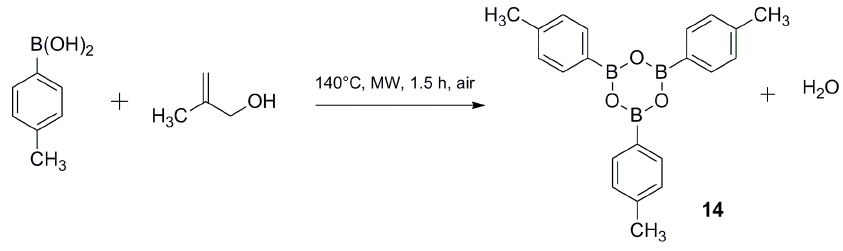
Figure 5. Conversion of boronic acid to boroxine when heating.